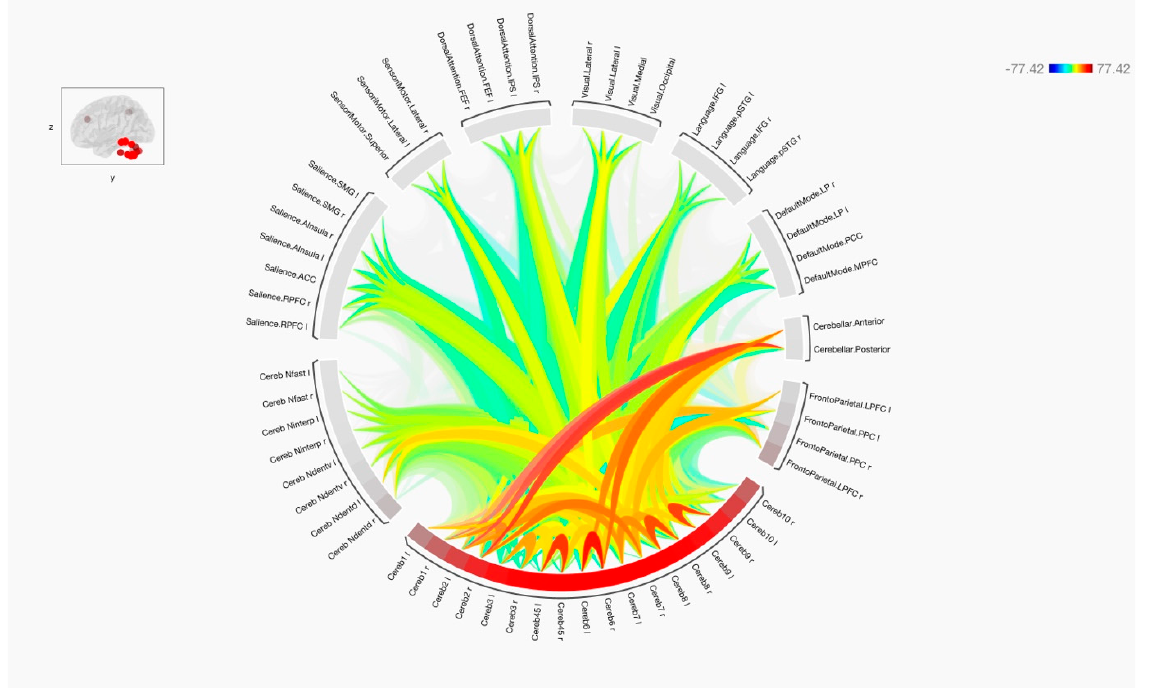
Figure 3. The functional connectivity of the cerebellar lobules and target regions is shown at the group level. The lines of the connections in red indicate positive connectivity, while blue indicates negative connectivity. The colors of the lines are proportional to statistical strength, and the T-bar is shown in the top right-hand corner.